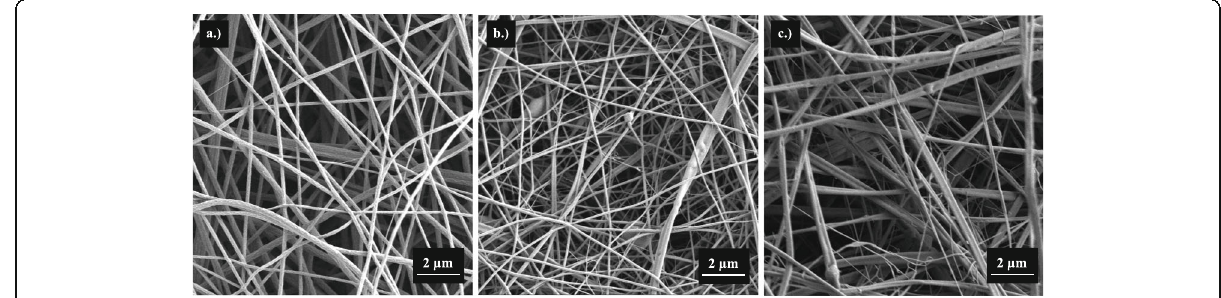
Fig. 2 Representative FESEM micrographs of electrospun scaffolds. a CS-PEO, mean diameter 269.9±68.4 nm. b CS-PEO/Fb, mean diameter 202.3± 113.2 nm. c Fb, mean diameter 351.1±101.7 nm ( n